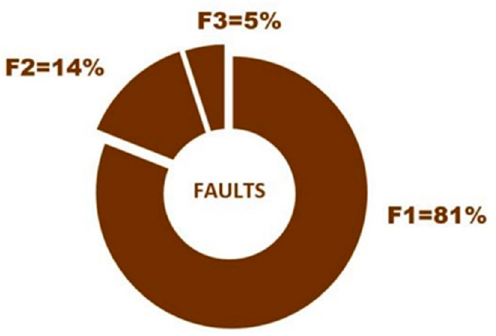
Figure 1. General percentages of the types of faults detected in the research.